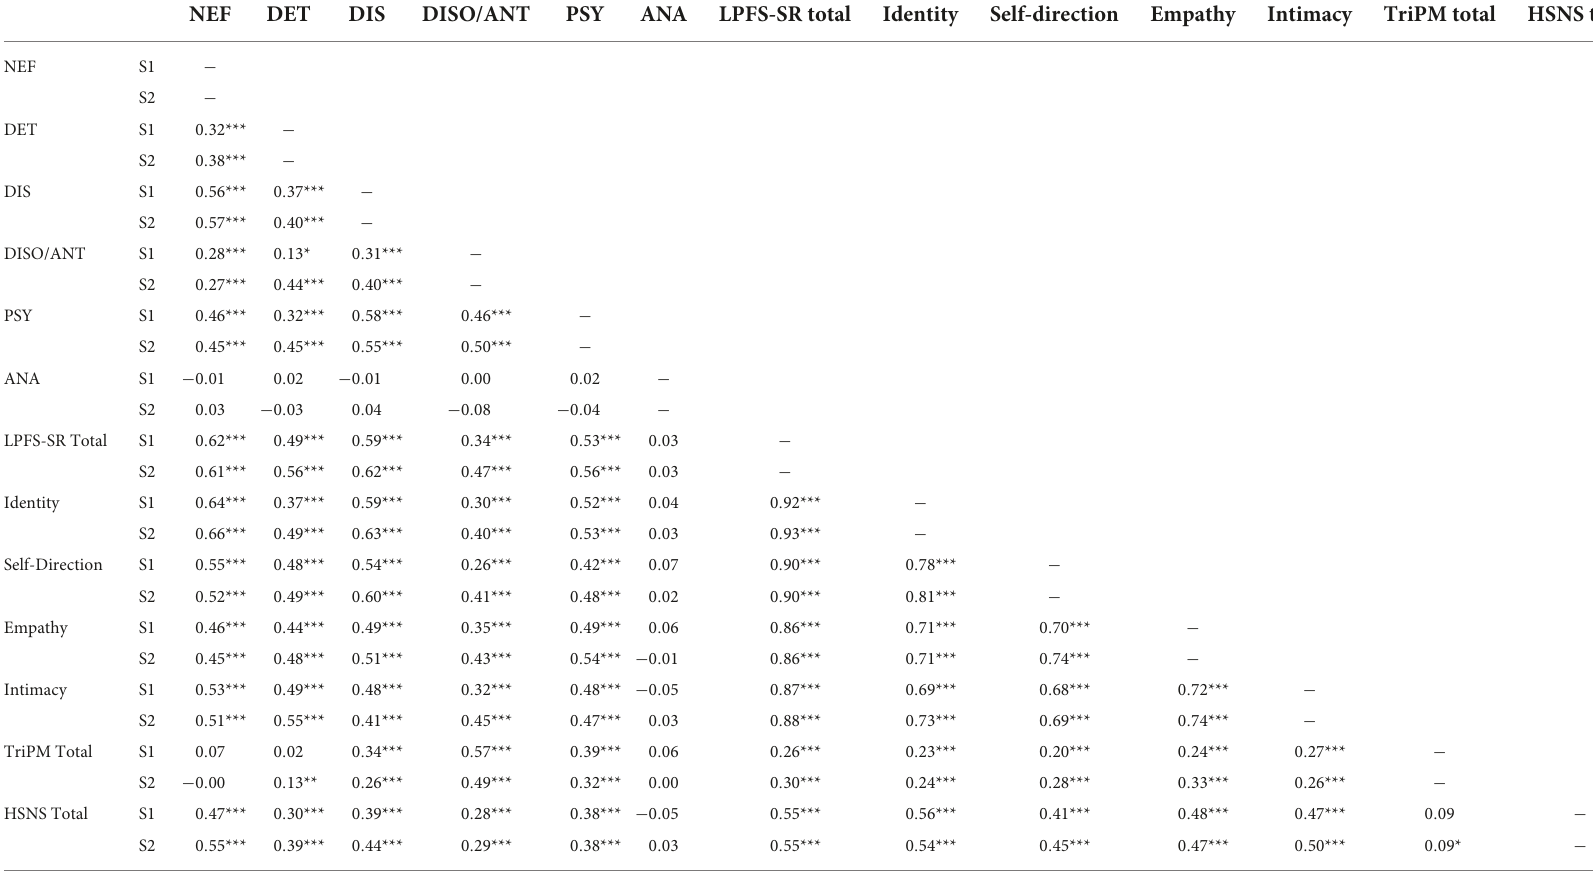
TABLE 3 Correlations between scales in both